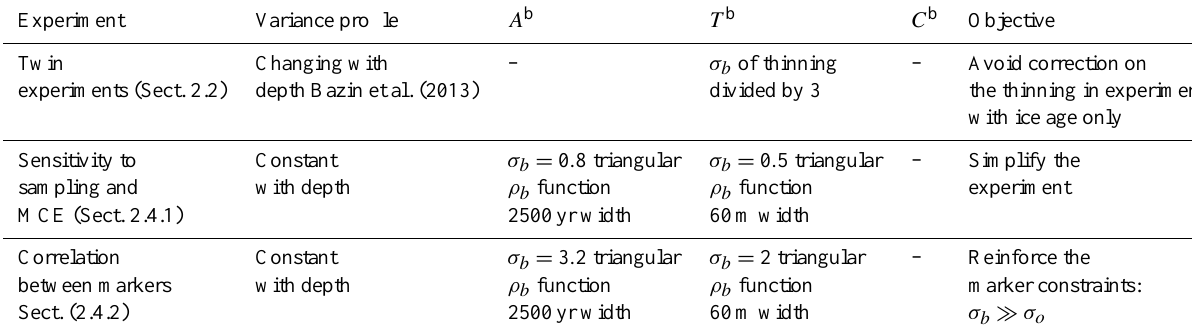
Table 4. Summary of the simulation configurations.